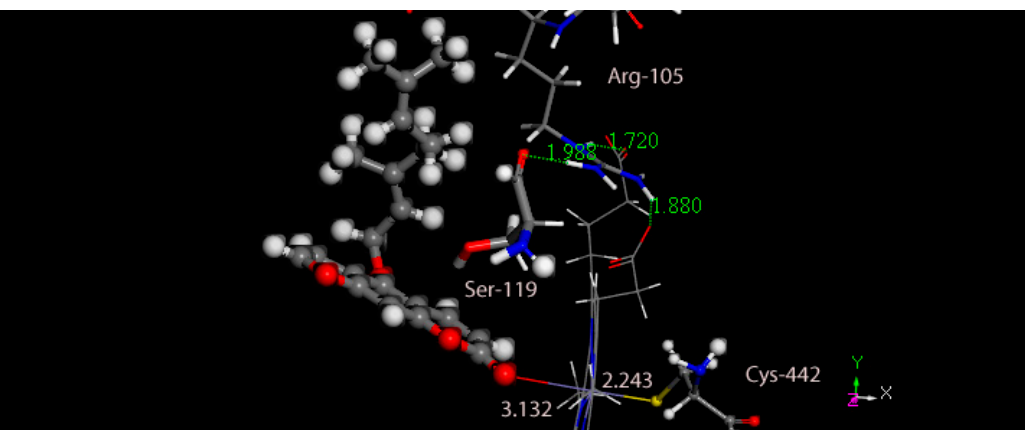
Figure 12. The main set of Berg5 atoms after DFT geometry optimization with Dmol3 including the amino acid residue, Ser − 119, located at the center (large stick style). Heme view is almost eclipsed and partially shown (line style); bergamottin (large ball and stick); Arg − 105 partially shown (small stick); iron coordinated Cis − 442 (small ball and stick). Iron confirms its bonding to S(Cys − 442), 2.243 Å, however, bergamottin O(carbonyl) gets markedly removed from the heme coordination sphere, d(O-Fe) = 3.132 Å. Ser − 119 remains linked via hydrogen bonding to Arg − 105 NH 2 , 1.998 Å, as does Arg − 105 to both heme carboxylates, 1.720 and 1.880